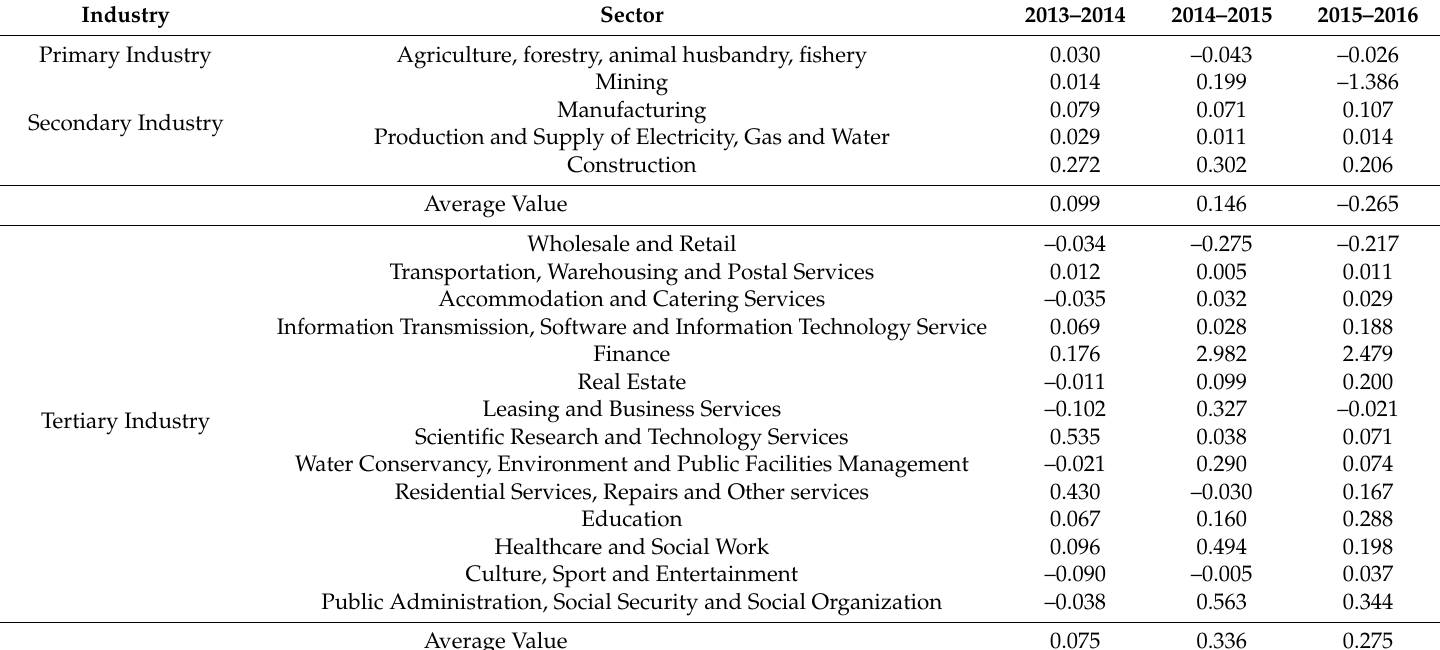
Table 7. Change effect of carbon productivity in Beijing